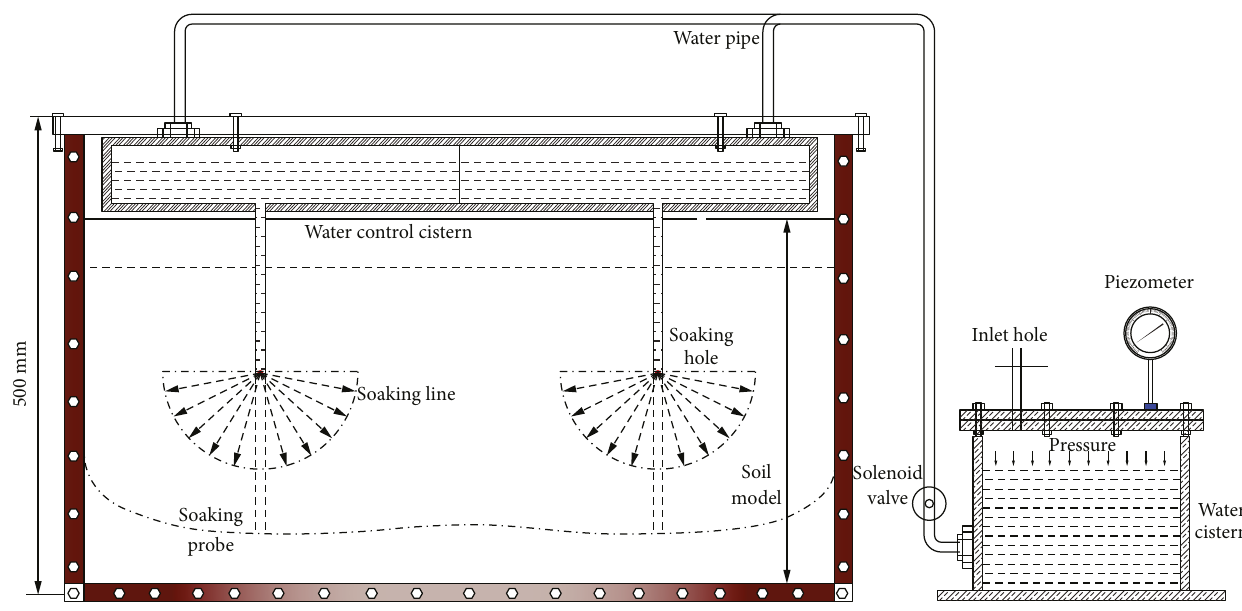
Figure 1: Design of water soaking system